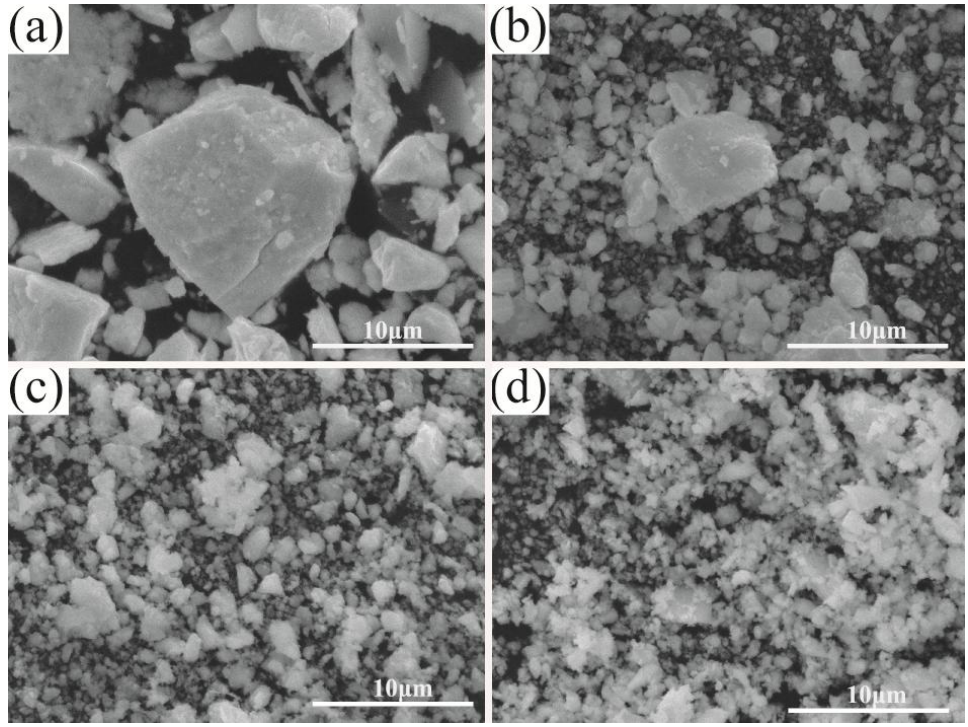
Figure 5. SEM images of Mn 55 Bi 45 powders obtained by LEBM at ( a ) 4 h, ( b ) 10 h, ( c ) 14 h, ( d ) 34 h.